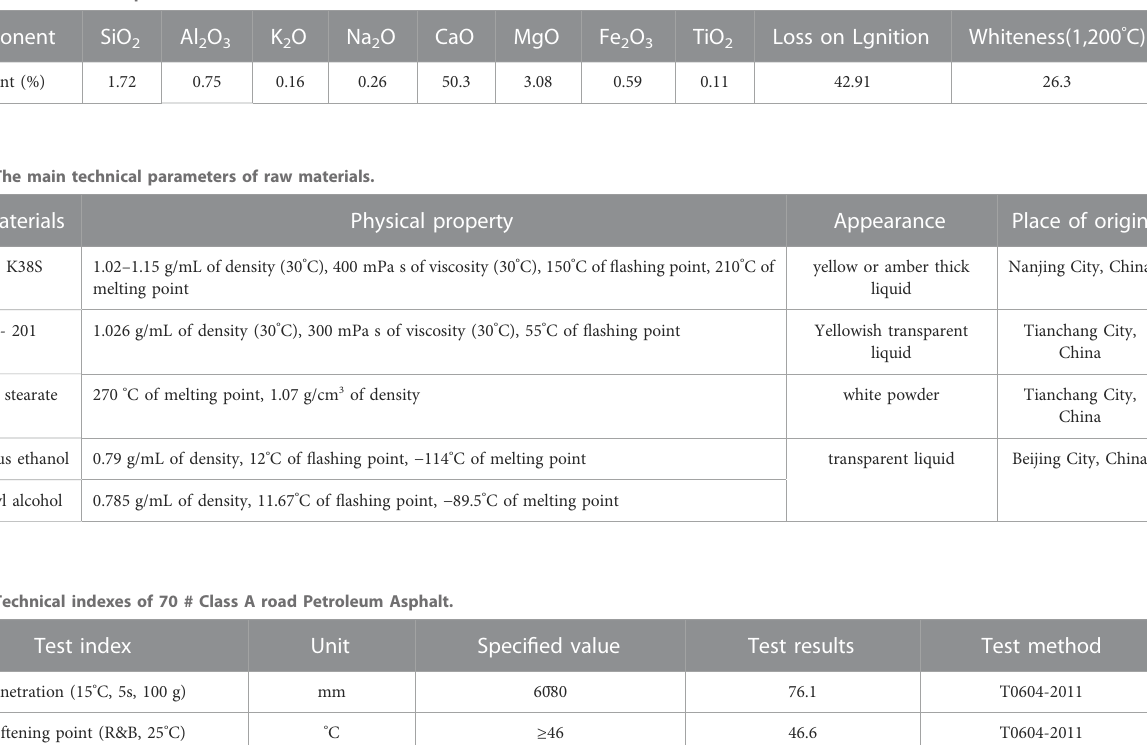
TABLE 1 The chemical component of raw materials.